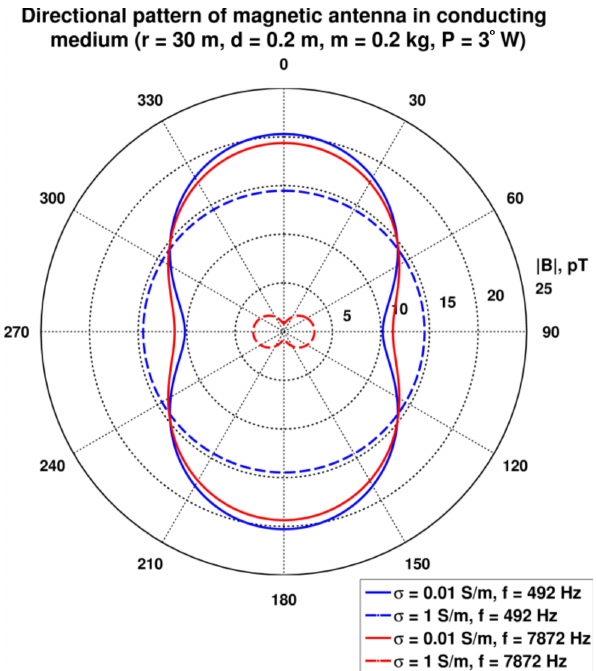
Figure 2. The directional pattern of the circular loop with a diam- eter of 0.2m and power dissipation of 3W for the distance of 30m depending on the conductivity σ and operation frequency f